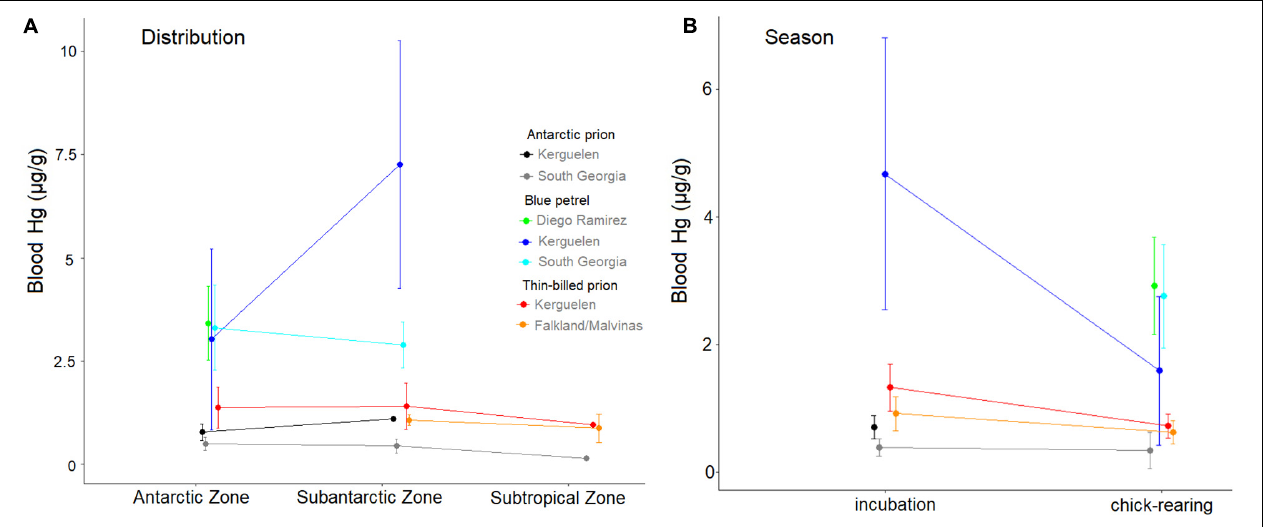
FIGURE 7 | Blood mercury concentrations in Blue Petrels, Thin-billed Prions, and Antarctic Prions, with effects of distribution (A) and the breeding season (B)